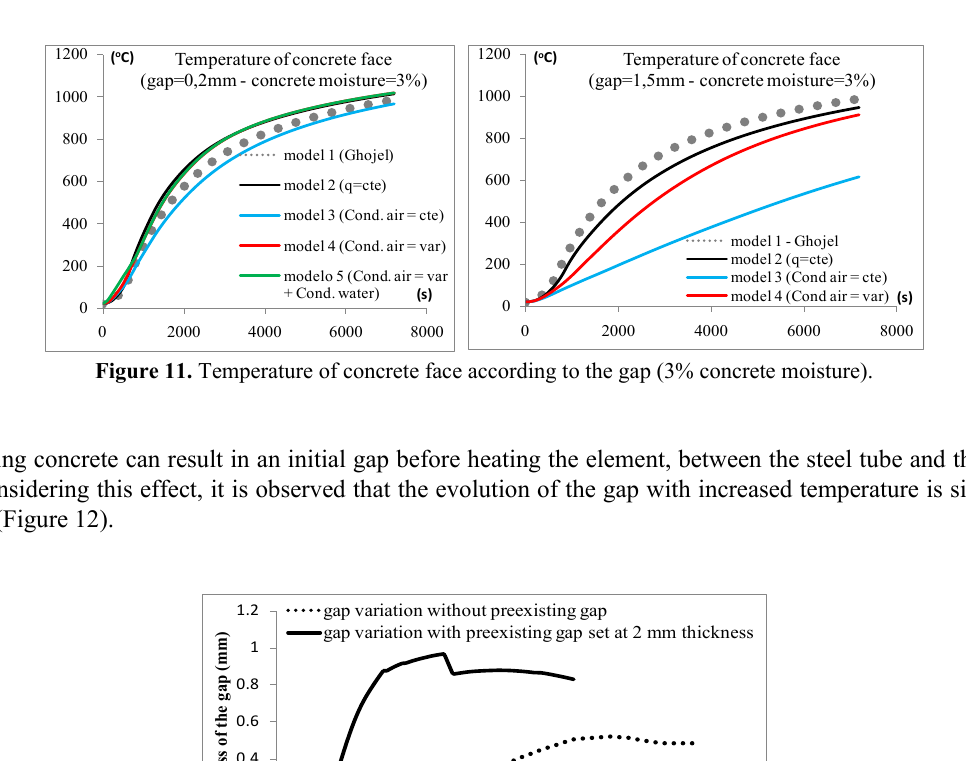
Figure 10. Temperature of steel tube according to the gap (3% concrete moisture).